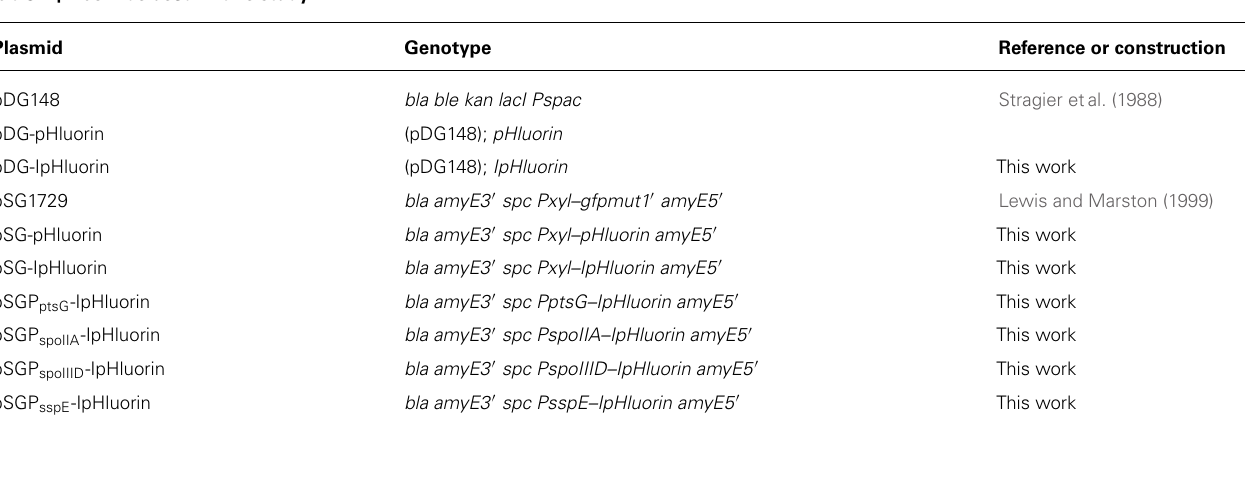
Table 2 | Plasmids used in this study.